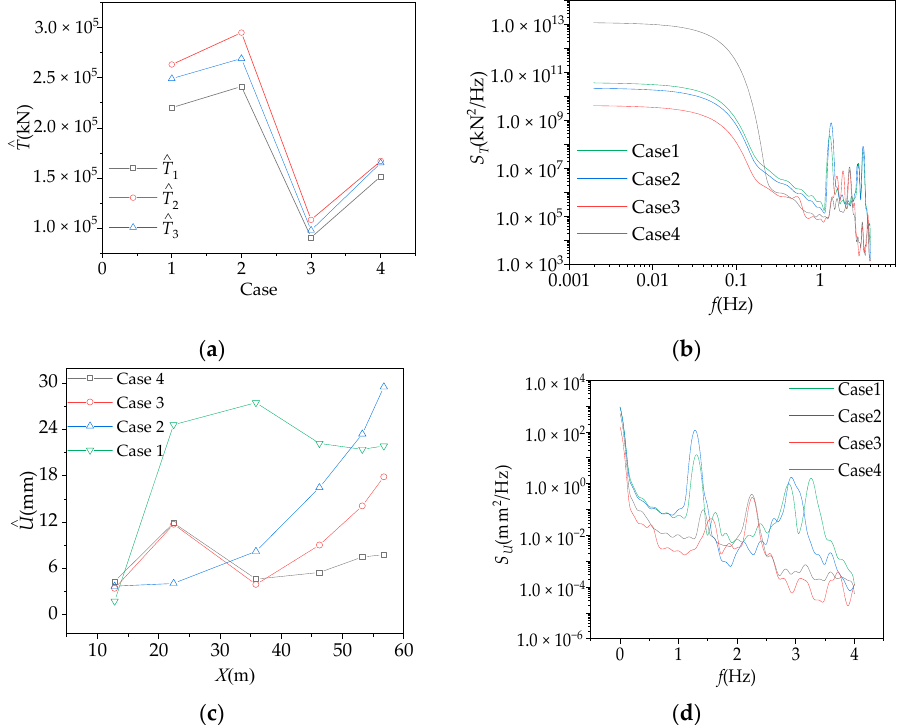
Figure 7. Analysis of wind ‐ induced response with a stayed cable layout: ( a ) peak tension analysis; ( b ) tension spectrum analysis; ( c ) peak displacement analysis; and ( d ) displacement spectrum analysis.